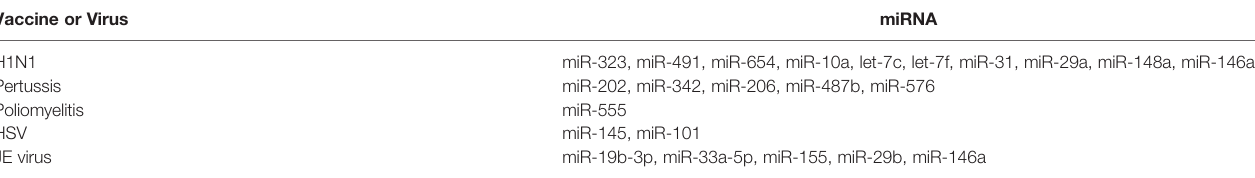
TABLE 5 | miRNAs biomarkers for vaccines or viruses related to anti-NMDA receptor encephalitis (10). Vaccine or